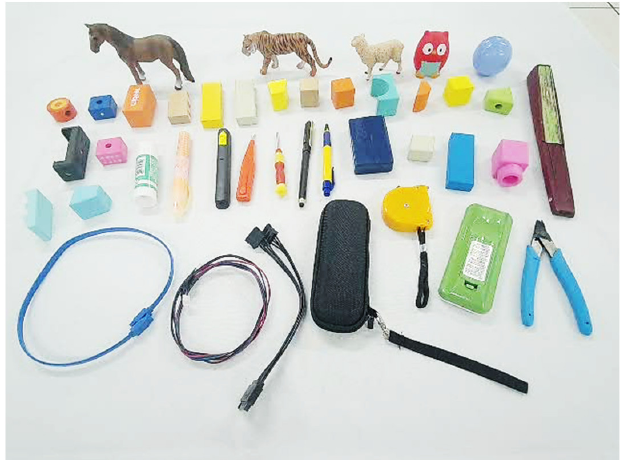
Figure 7. Realistic scenario experiment setup. The experimental equipment includes the Elite EC-66 robot, the Fin Ray effect-inspired soft parallel gripper and the Orbbec Femto-W RGB-D camera.